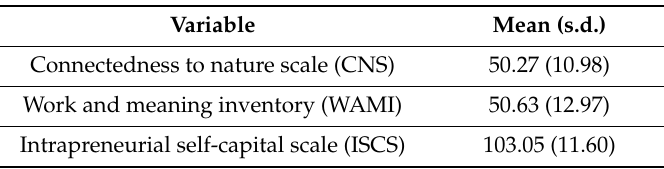
Table 1. Descriptive Statistics.